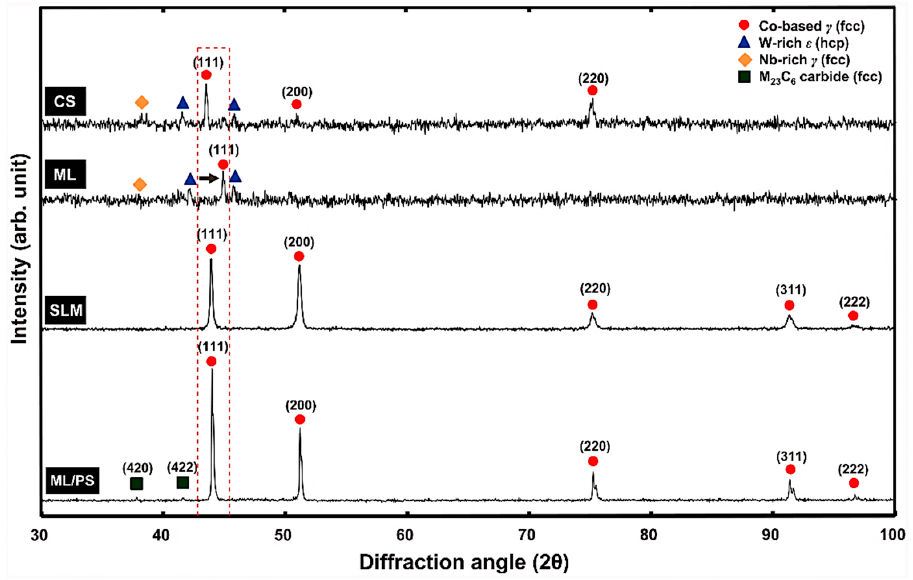
Figure 10. CoCr alloy exhibiting the dominating γ -FCC phase with different manufacturing processes